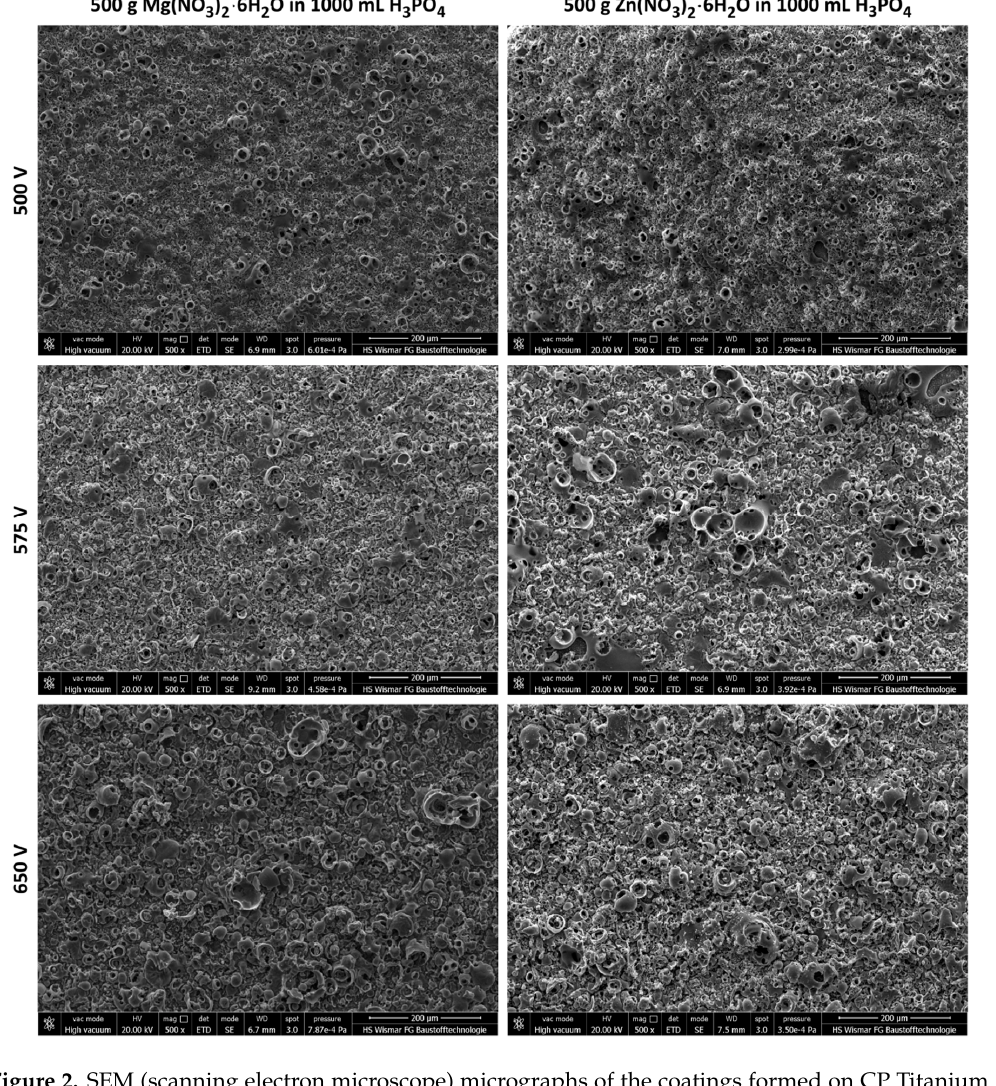
Figure 2. SEM (scanning electron microscope) micrographs of the coatings formed on CP Titanium Grade 2 after PEO treatment at voltages of 500 V, 575 V, 650 V in H 3 PO 4 electrolyte with addition of